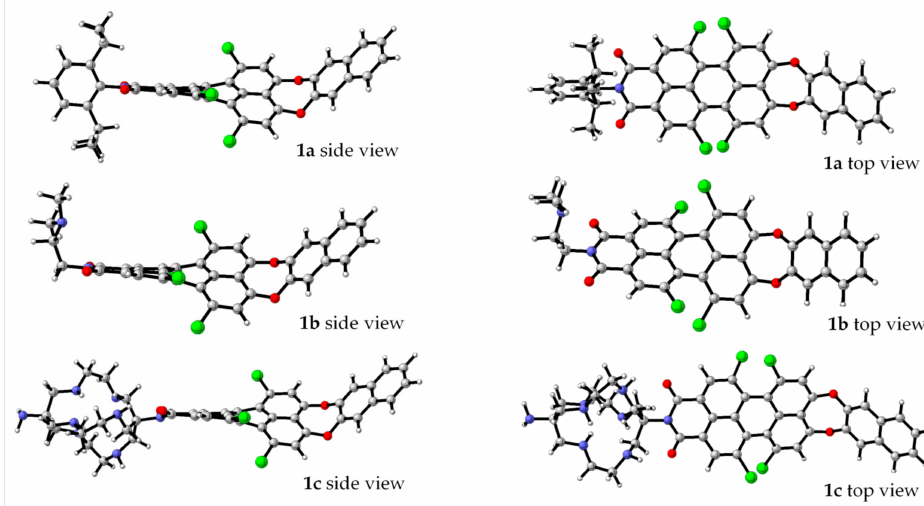
Figure 2. B3LYP/6-31G(d,p) optimized geometries of 1a–c in methanol